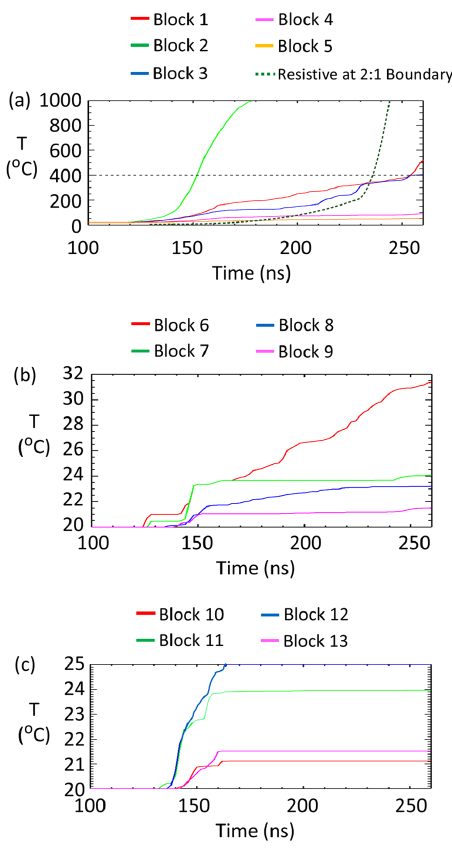
FIG. 22. The maximum temperature rise of any cell on the anode in the indicated block is shown as an integrated measure of local electron loss for (a) blocks 1 – 5, (b) blocks 6 – 9, and (c) blocks 10 – 13. Only block 2 has sufficient losses to heat the anode to 400 °C and turn on ion emission. Resistive heating at the inner radius of the CSMITL ( r ¼ 0 . 08 m and the boundary between blocks 1 and 2) is shown as the dashed green curve, labeled “ Resistive 2:1 ” in